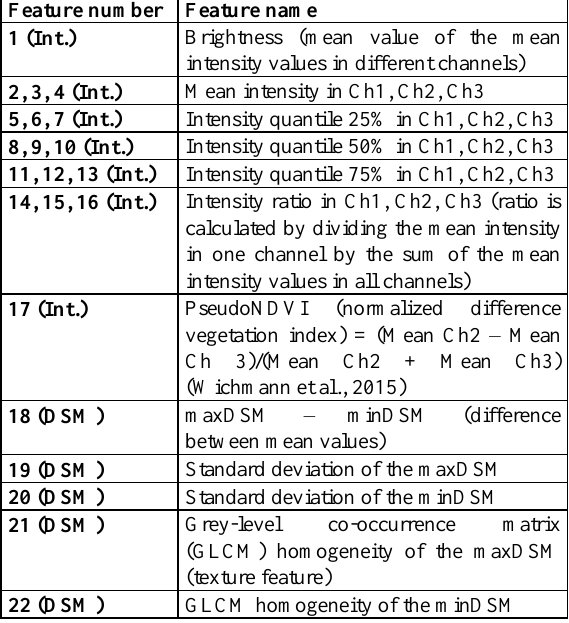
Table 1. Features used in the classification analysis. “Int.” refers to intensity features and “DSM” refers to DSM features.